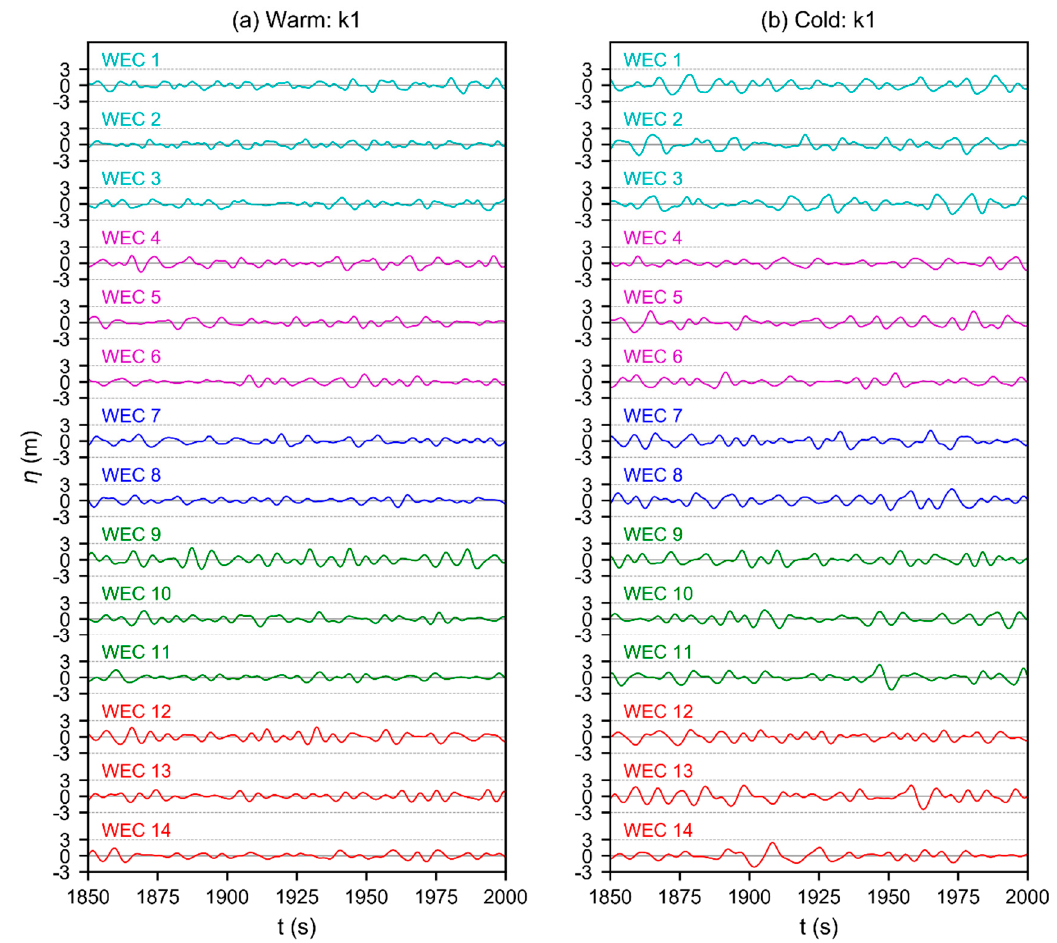
Figure 5. Sample time series of sea-surface elevation at all virtual WEC stations, color-grouped by distance from shore. ( a ) Warm months, first realization, and ( b ) cold months, first realization.